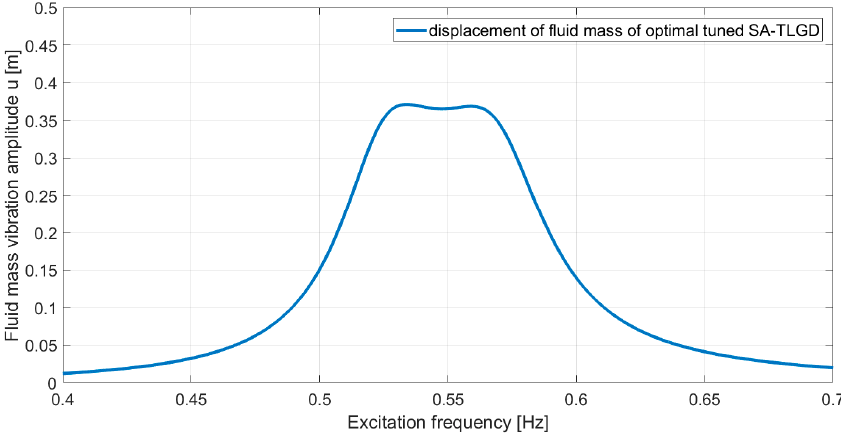
Figure 6. Frequency response function (FRF) of the activated optimally tuned SA-TLGD (steady state response of the fluid mass displacement amplitude u ).